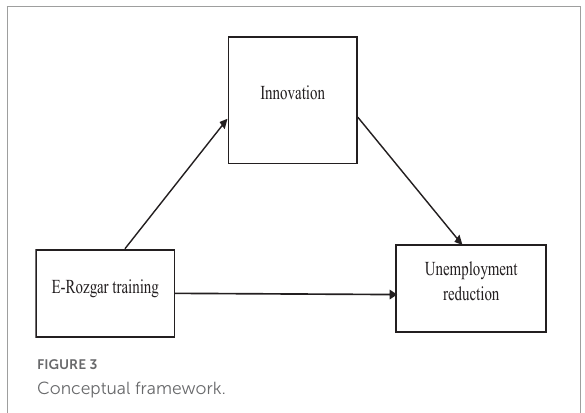
FIGURE3 Conceptual